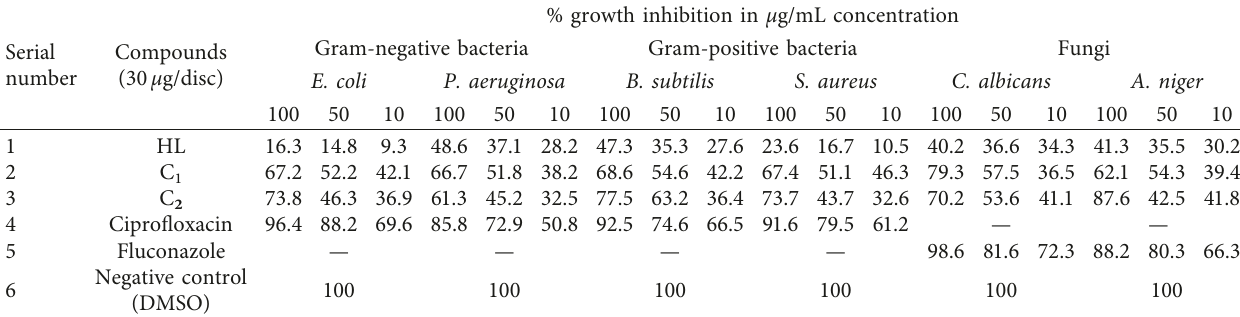
Table 5: Antimicrobial results of HL and its metal complexes.